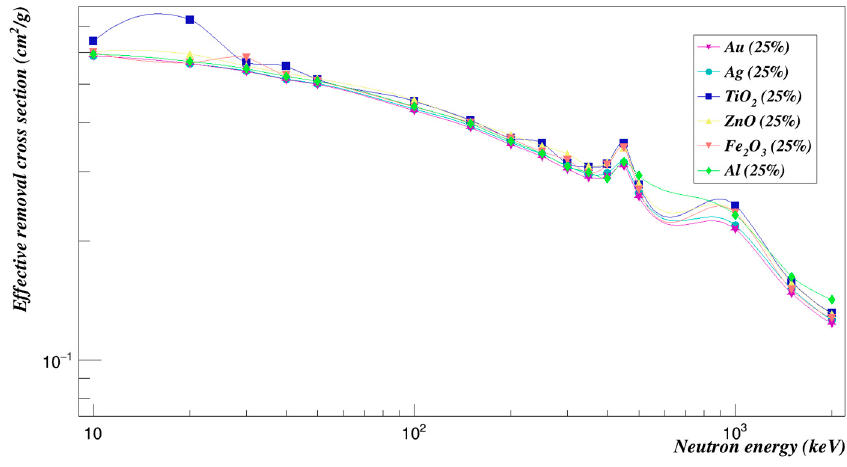
Figure 19. E ff ective removal cross sections of Polyimide doped with 25% of di ff erent composites. Figure 19. Effective removal cross sections of Polyimide doped with 25% of different composites. The same comparison was made on the neutron effective removal